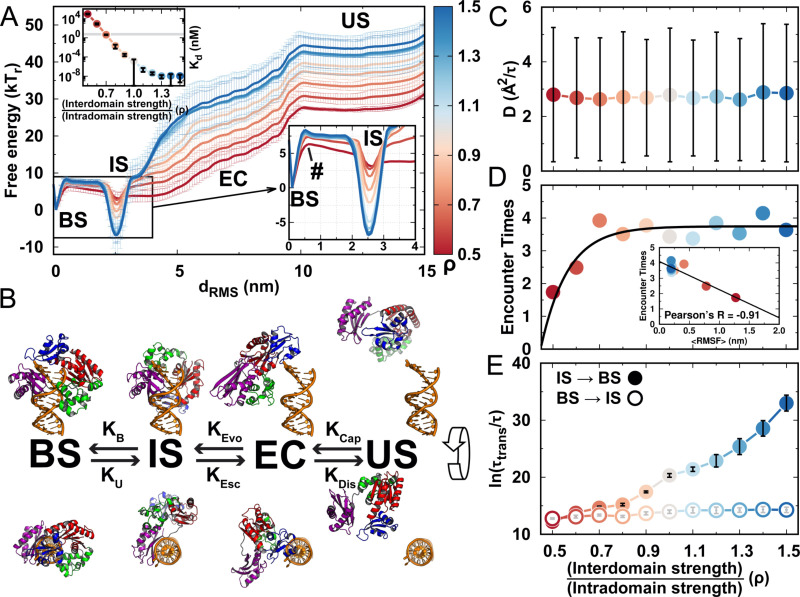
DPO4–DNA binding thermodynamics and kinetics.(A) 1D free energy landscape of DPO4–DNA binding versus the distance root-mean-square deviation of DPO4–DNA binding native contacts dRMS for different values of ρ. dRMS has units of length and deviates from 0 nm as unbinding proceeds. The binding process can be divided into four states: US, EC, IS, and BS. The insert at the top left shows the binding affinity for different values of ρ, with the gray line corresponding to the experimental measurements (3–10 nM). The insert at the bottom right is a magnified view of the binding free energy landscape focusing on the transition between the BS and the IS. The error analysis was done by performing four independent umbrella sampling simulations with different initial conditions. Error bars are omitted from this insert for clarity. (B) The four-state DPO4–DNA binding process. Typical corresponding DPO4–DNA structures obtained from the simulations for different binding states are shown from two perpendicular viewpoints. There are three transitions in the four-state DPO4–DNA binding process. The ρ-dependent DPO4–DNA binding kinetics in terms of these three transitions are shown in (C–E). (C) Diffusion coefficient D of free DPO4 (in the absence of DNA) for different values of ρ. D reflects the essence of KCap. Error bars represent the standard deviations from the corresponding mean values of D. τ is the reduced time unit. (D) Encounter times of the EC evolving to the IS with different values of ρ. The encounter time was calculated from the expression kDis/kEvo+1. The insert is a plot of encounter times versus the mean root-mean-square fluctuation (RMSF) of DPO4 in the free state. The mean RMSF was obtained from the free DPO4 simulations by averaging all the residues in DPO4 (Figure 4—figure supplement 3). (E) Transition times τtrans between the BS and the IS for different values ρ. τtrans was calculated from 100 independent simulations, and the errors were estimated by a bootstrap analysis with 50 subsamples.